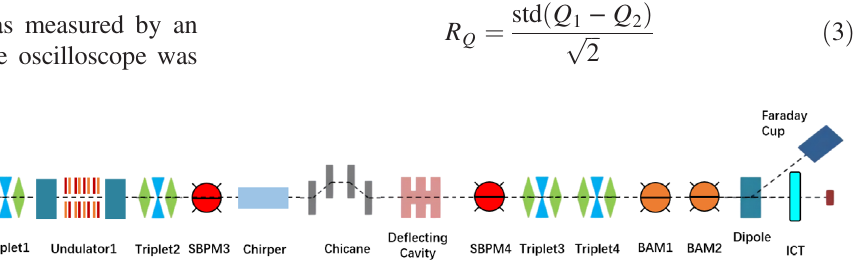
FIG. 10. Schematic diagram of the THz